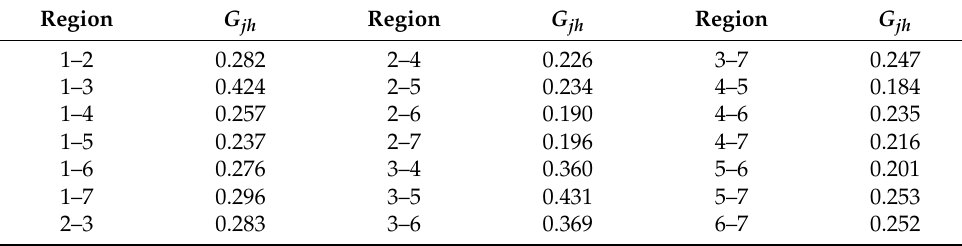
Table 6. Annual average values of inter-basin differences of EWP in the Poyang Lake area from 2007 to